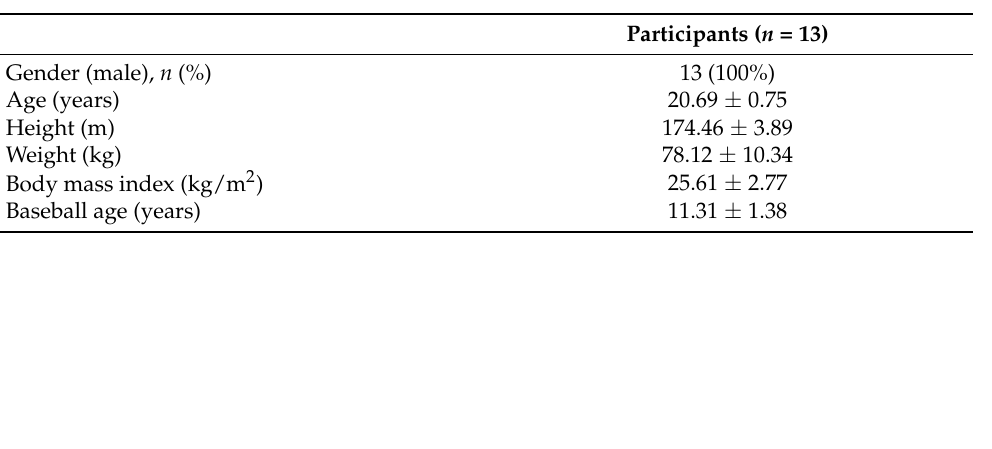
Table 1. All participants’